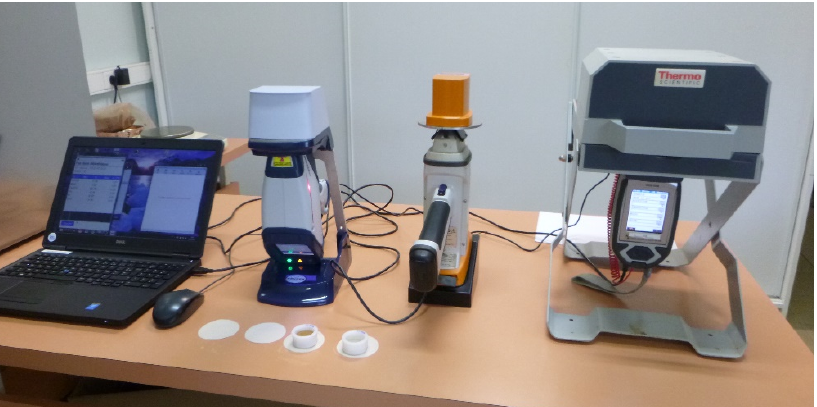
Figure 4. Presentation of the three pXRF devices and their stands during the measurement phase of wetted samples in the lab.